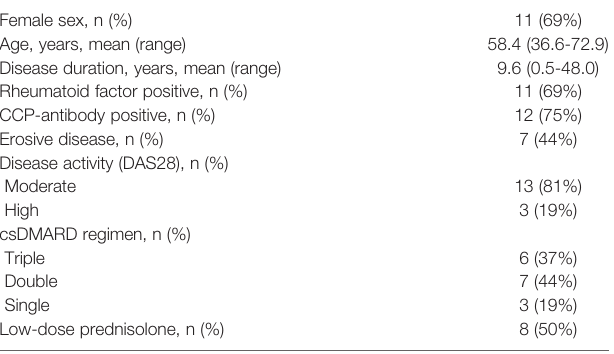
TABLE 1 | Characteristics of the patients